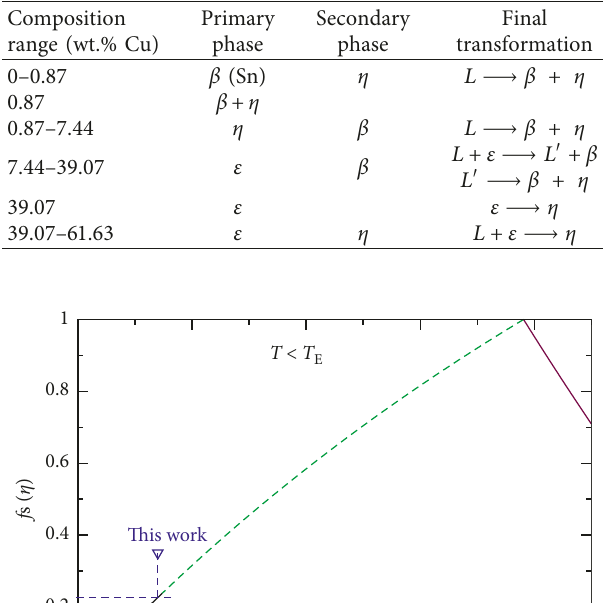
Figure 5: Sn-Cu equilibrium phase diagram. Table 1: Solidification path of Sn-Cu alloys with different compositions.